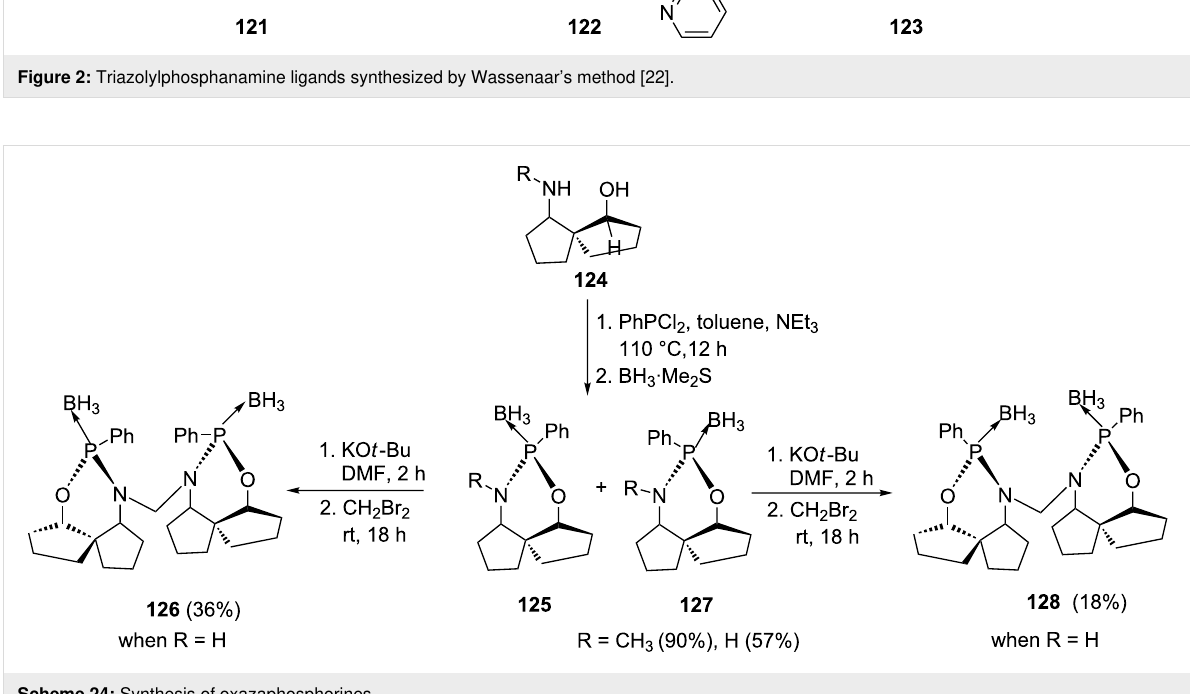
Scheme 24: Synthesis of